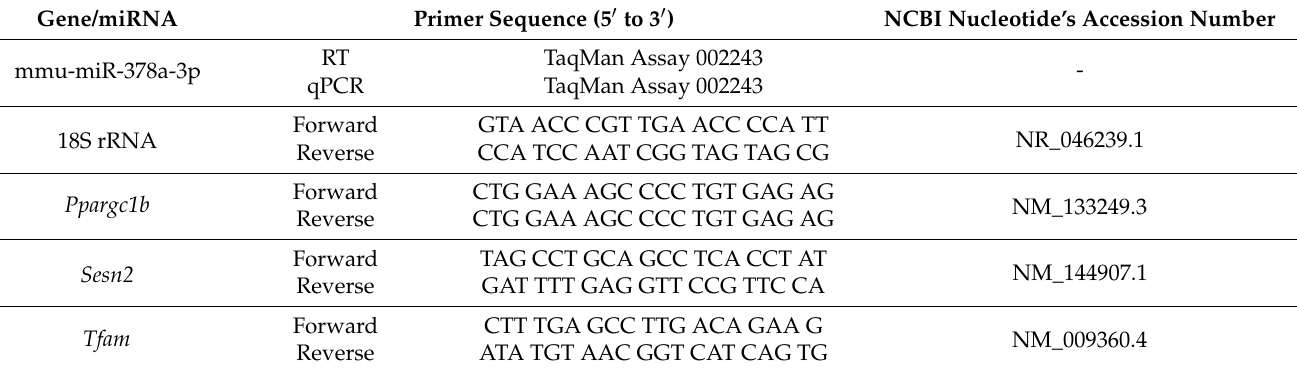
Table 1. Nucleotide sequence of primers used in RT-qPCR. Gene/miRNA Primer Sequence (5 (cid:48) to 3 (cid:48) ) NCBI Nucleotide’s Accession Number mmu-miR-378a-3p -